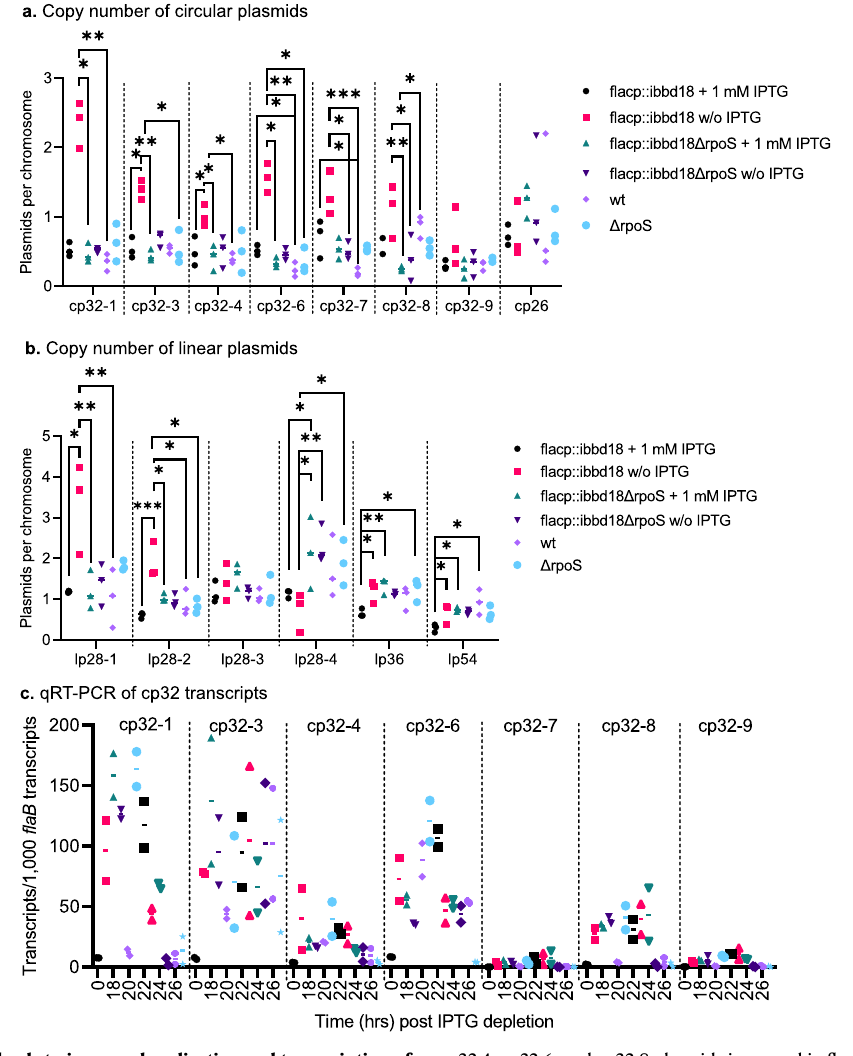
cp32-4, cp32-6, and cp32-8 plasmids increased in fl acp::ibbd18 following IPTG depletion of a culture started at 10 6 spirochetes per ml. Data are presented in all graphs as individual values of biological replicates with the mean value indicated. 5a-b n =3 biological replicates. 5c n =2 biological replicates. * p value<0.05, ** p value<0.005, *** p